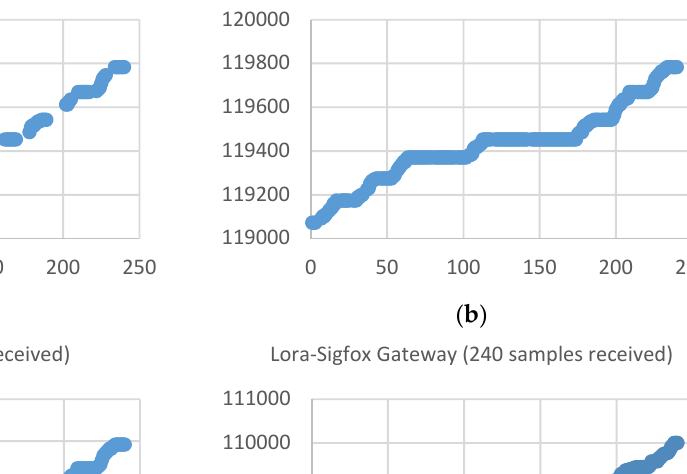
Table 2. Reception rates over a period of 10 days (240 samples) with each of the different systems tested in a water-meter with a percentage of received samples ranged within 25%–75% over expected in the 169MHz ISM band.